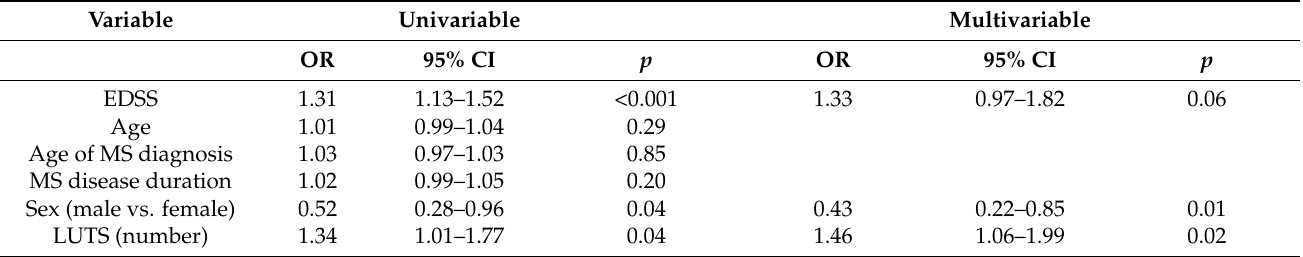
Table 4. Univariable and multivariable logistic regression analysis prediction at least one urodynamic risk factor of UUT deterioration in patients with